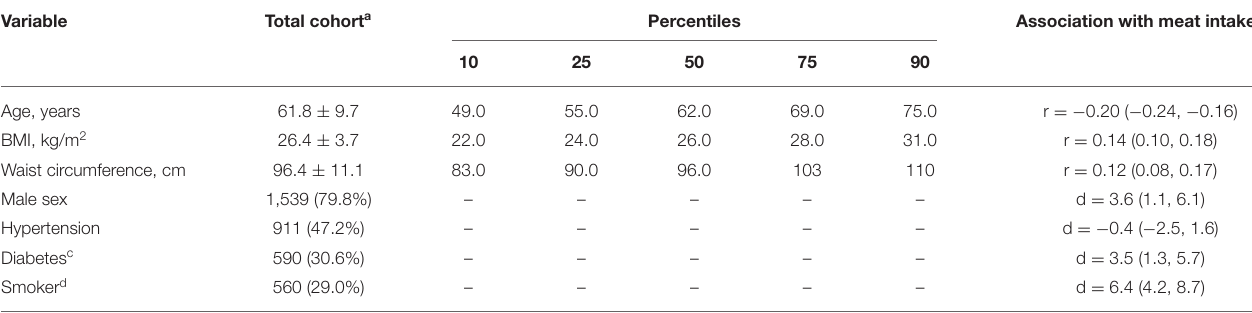
TABLE 1 | Key characteristics of the patients included in the study ( n = 1,929).